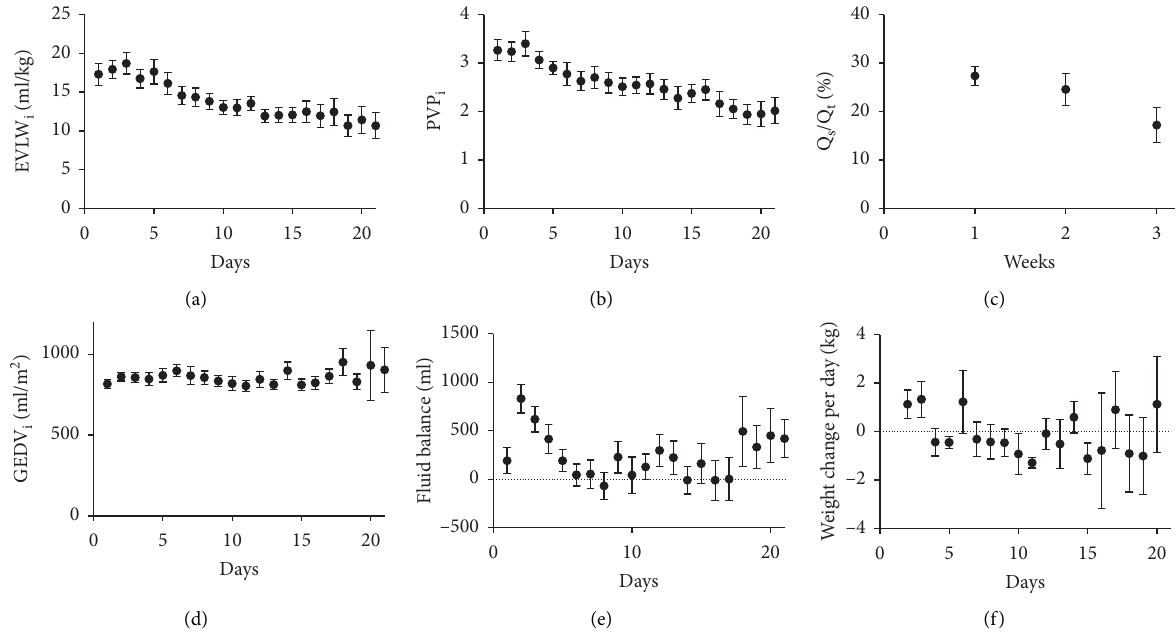
Figure 3: Circulatory characteristics (III) of COVID-19 patients. EVLW i : extravascular lung water index; PVP i : pulmonary vascular permeability index; Q s /Q t : pulmonary shunt fraction; GEDV i : global end-diastolic volume